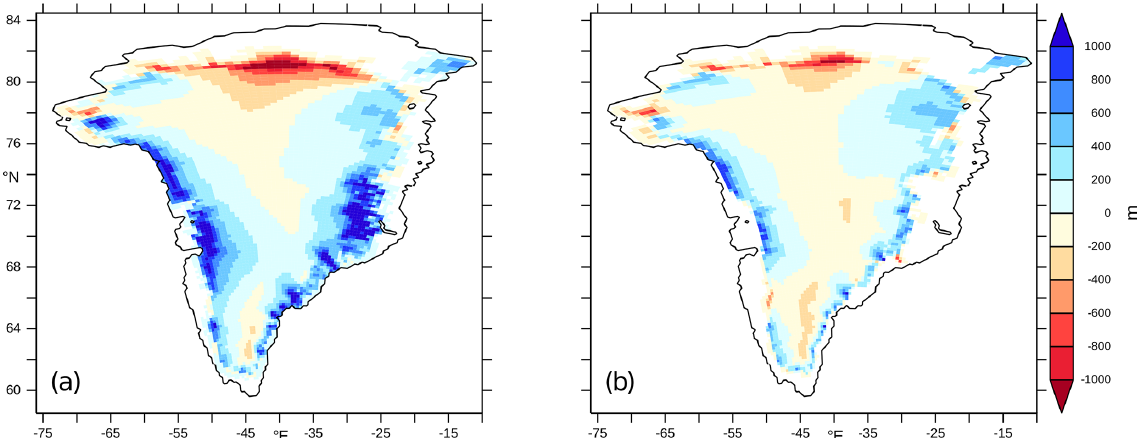
Figure 10. Change in Glimmer ice thickness (m) at the end of the spin-up periods shown in Fig. 9. Calving is imposed either (a) at the marine margin as resolved on the Glimmer grid or (b) near the initial ice